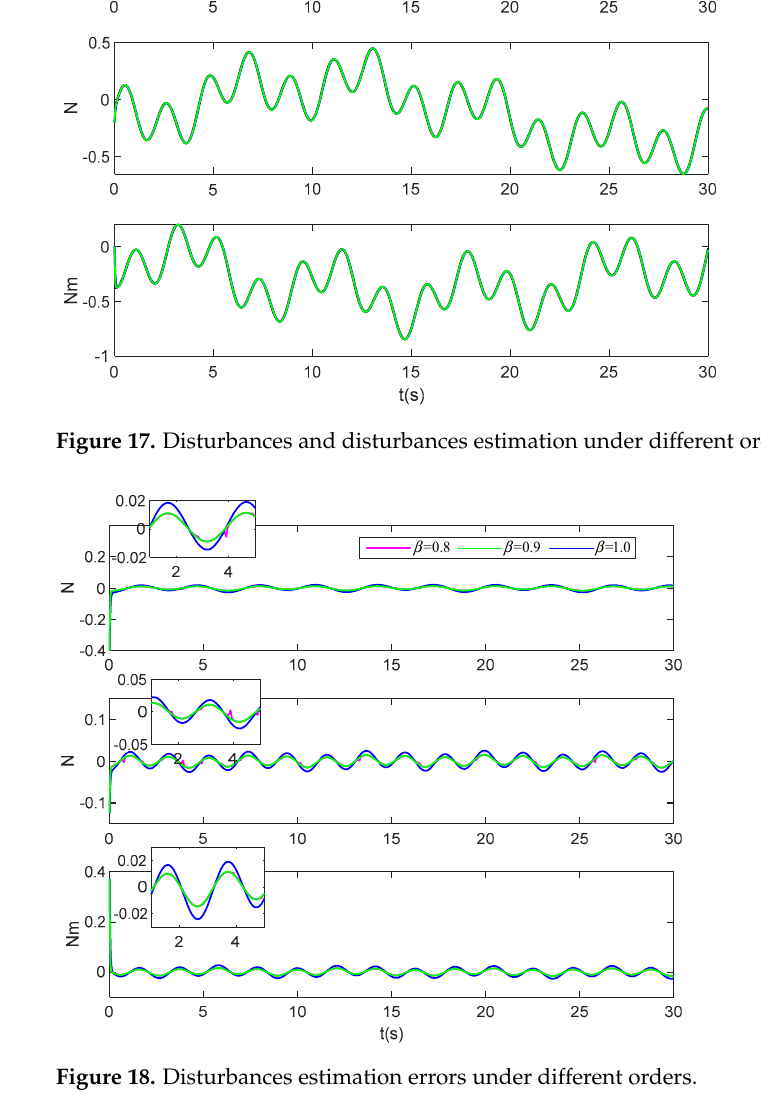
Figure 18. Disturbances estimation errors under different orders.